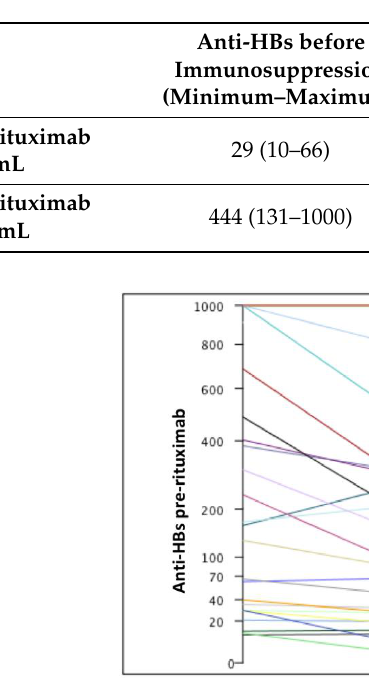
Table 3. Median anti-HBs titers before and after rituximab therapy categorized by anti-HBs before